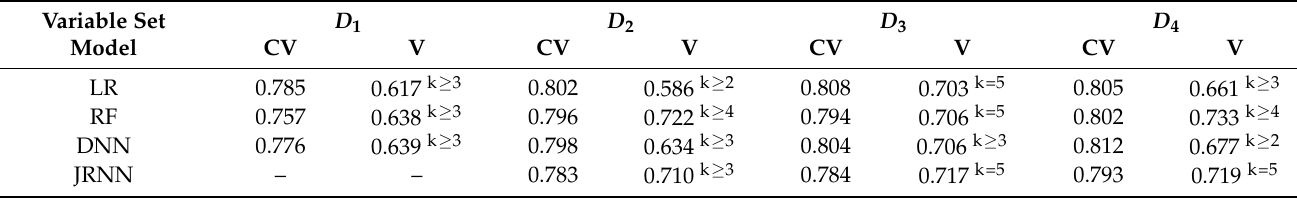
Table 6. Cross-validation (CV) and test F 1 scores across model types and variable sets. The k -fold consensus threshold that yields the best verification F 1 score is denoted in superscripts. Variable